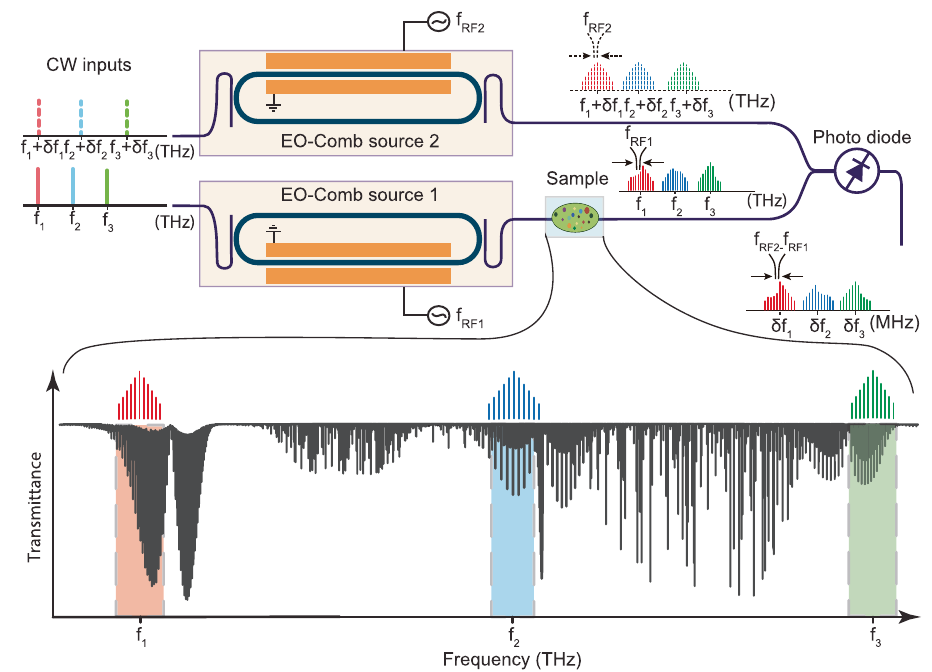
Fig. 1 Spectrally-tailored dual-comb spectroscopy with microring electro-optic (EO) frequency combs. In this conceptual representation, three narrow continuous-wave (CW) laser lines of frequency f 1 , f 2 , and f 3 are used to excite the optical modes of a resonant EO modulator, driven at the microwave frequency f RF1 that corresponds to the resonator free spectral range. The generated composite comb contains three non-adjacent combs, centered at f 1 , f 2 , and f 3 , each having comb line spacing of f RF1 . Central frequency and span of each of the three combs are chosen to interrogate targeted features in an absorbing sample, while leaving out regions without absorber or with interfering species, and can be adjusted independently with agility. Three slightly frequency-shifted replica of the original laser lines are produced and injected into a second resonant EO modulator, driven at a slightly different repetition frequency f RF2 , providing a reference spectrum. The interrogating and reference comb beams interfere on a fast photodetector. In this process, pairs of comb lines, one from each beam, produce a composite radio-frequency (RF) comb of line spacing f RF2 -f RF1 , mapping the spectral information from the optical domain, centered at f 1 , f 2 , and f 3 to the RF domain, centered at δ f 1 , δ f 2 , δ f 3 , respectively. The frequency agility of the resonant EO modulator is a unique feature that enables on demand spectral tailoring and optimization of the signal-to-noise